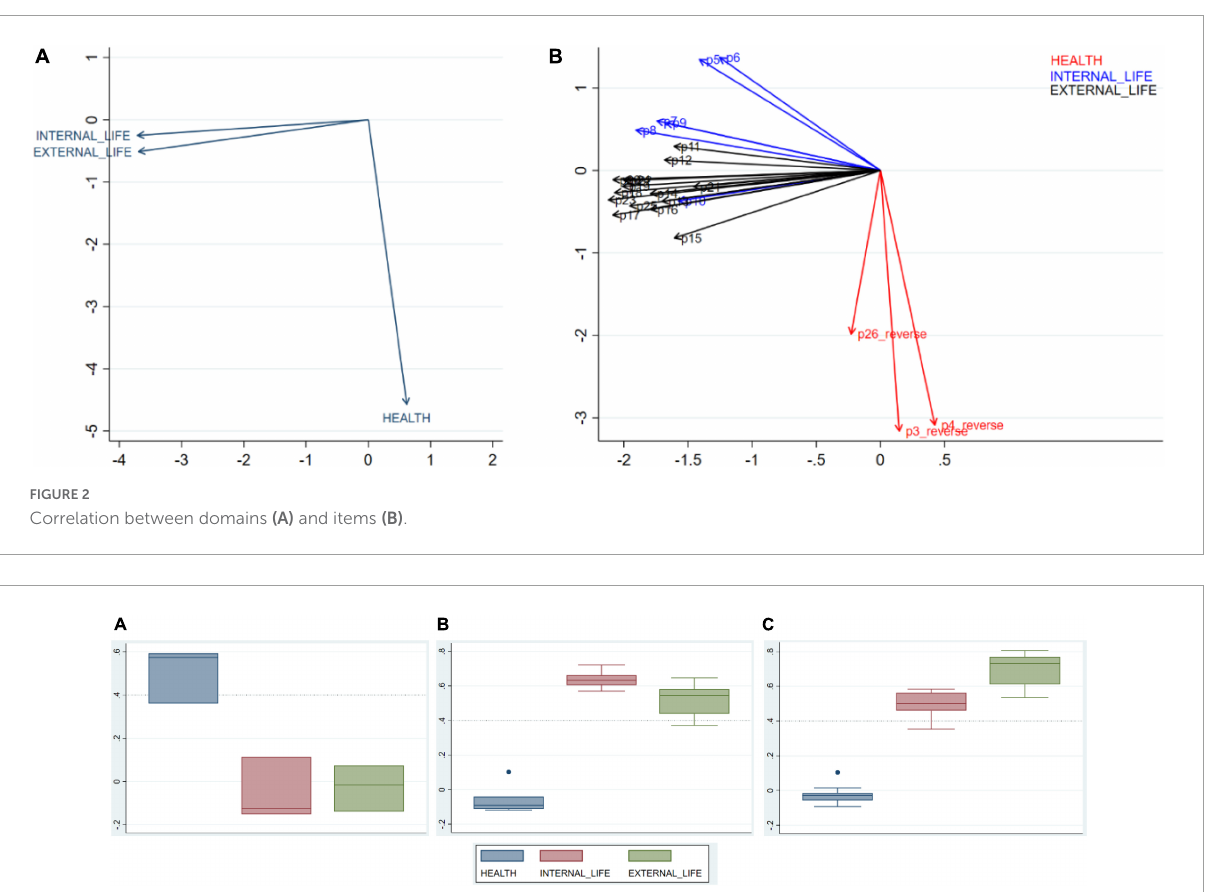
FIGURE3 Correlations between items of each domain and other domain scores. (A) Items of domain “physical and mental health”; (B) items of domain “internal life”; (C) items of domain “external life.”